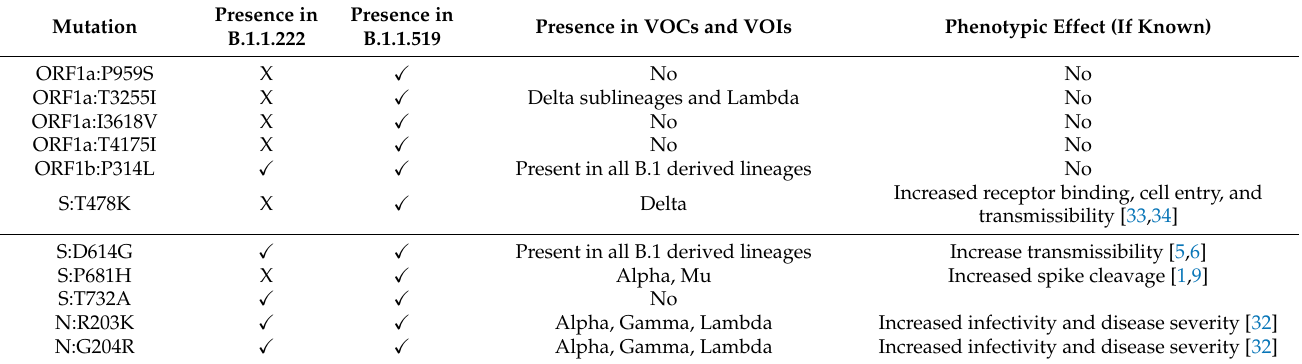
Table 2. Reported mutations in lineages B.1.1.222 and